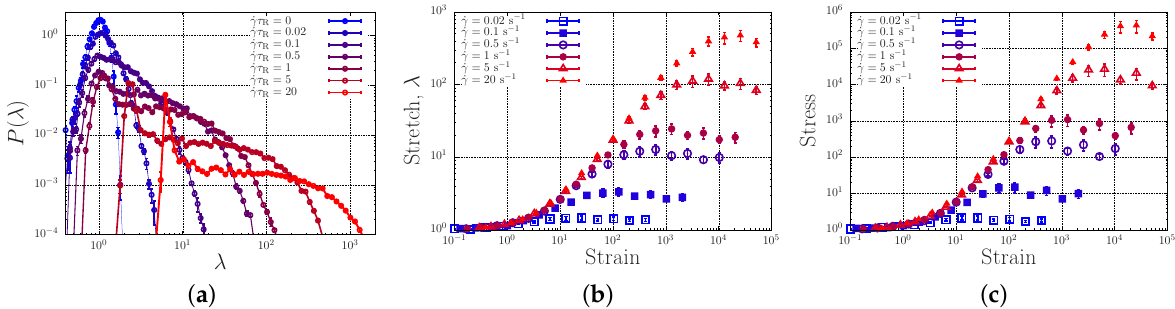
Figure 8. ( a ) Probability density distribution of the chain stretch ratio, λ at various shear rates. ( b ) Stretch as a function of the strain, ˙ γ t , at various various shear rates. ( c ) Stress corresponding to the stretch in panel ( b